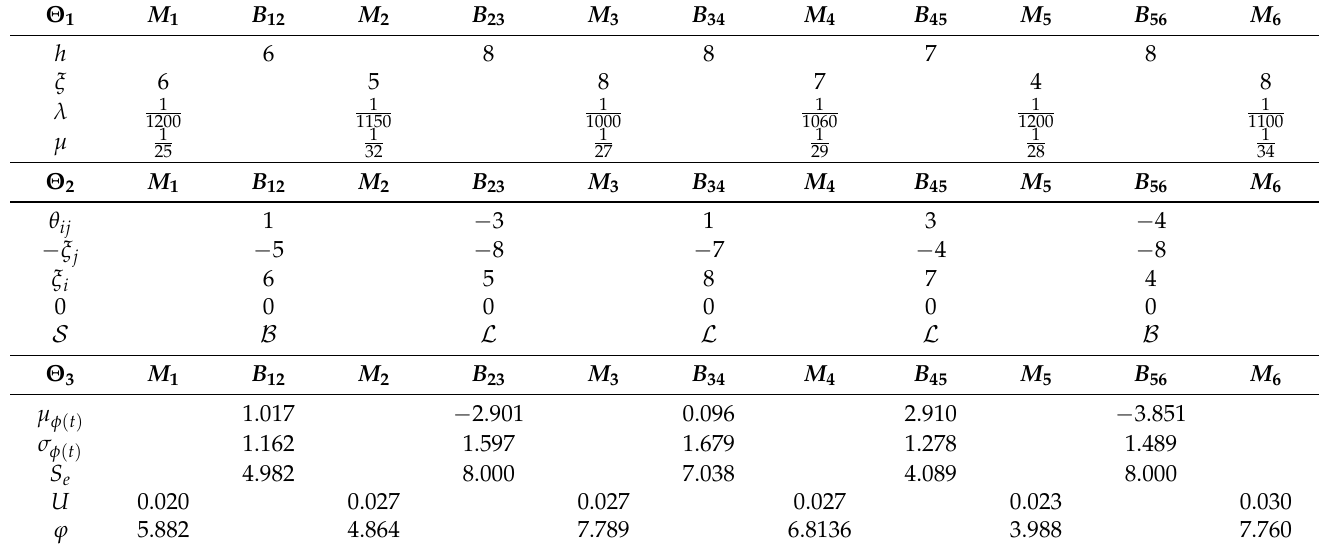
Table 1. Parametric values and results obtained from the takes all